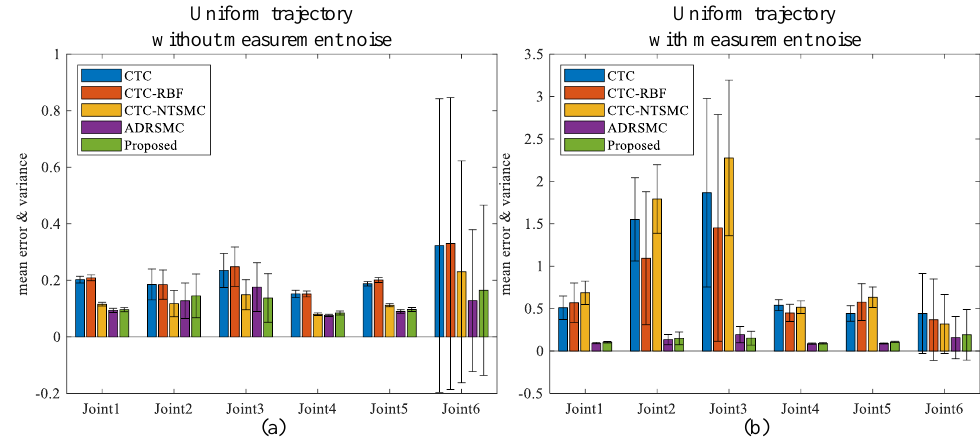
Figure 7. Comparison of mean error and variance of joint position for uniform trajectory tracking. ( a ) the results without the addition of joint measurement noises, ( b ) the results with the addition of joint measurement